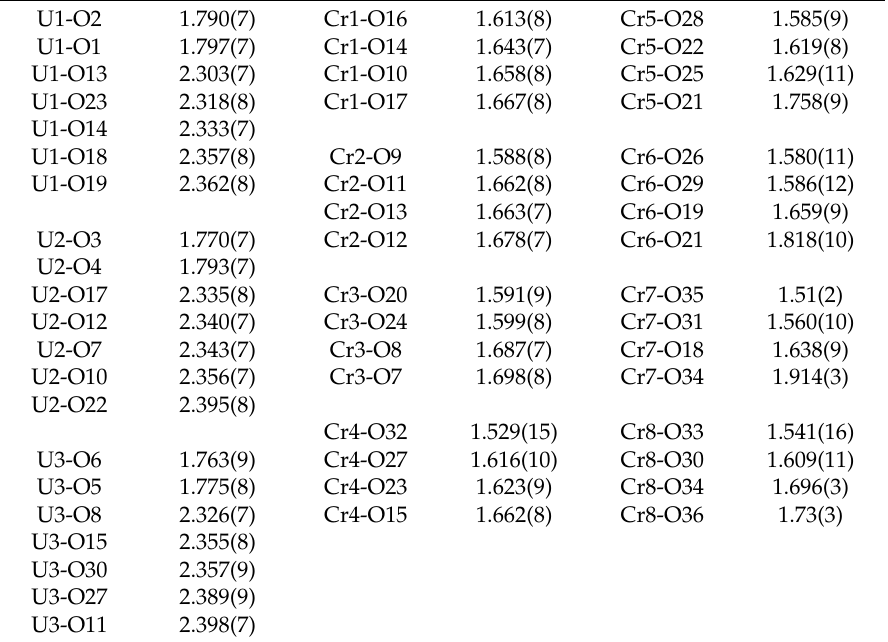
Table 4. Selected interatomic distances (Å) in 3